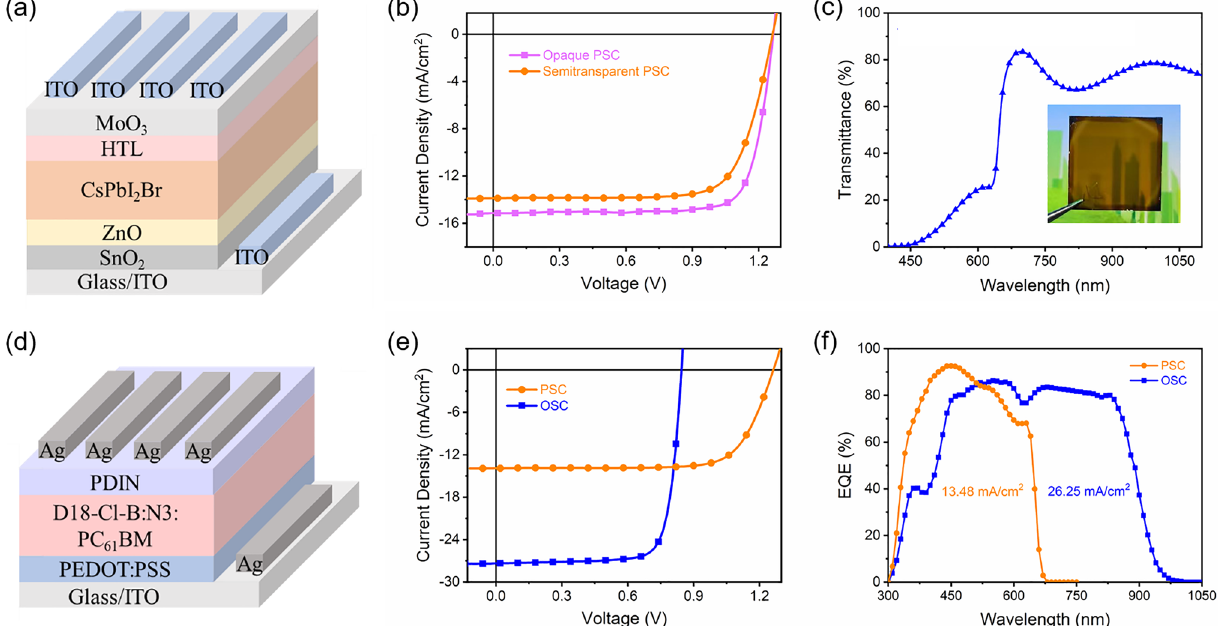
Fig. 2 a structure of the semi-transparent CsPbI 2 Br solar cells. b J–V curves for the opaque and semi-transparent CsPbI 2 Br solar cells. c Trans- mittance spectrum for the semi-transparent CsPbI 2 Br solar cell. The inset shows a photo for the semi-transparent CsPbI 2 Br solar cell. d structure of the organic solar cells. e J–V curves for the semi-transparent CsPbI 2 Br solar cells and organic solar cells. f EQE spectra for the semi-transpar-